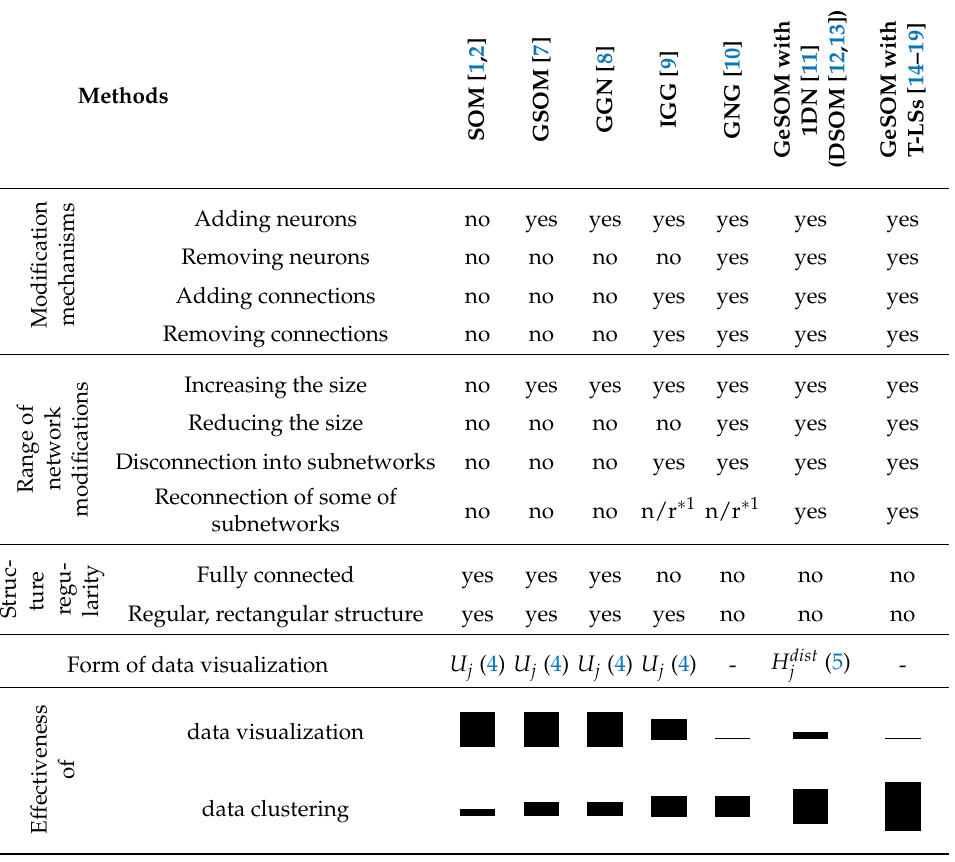
Table 1. Various modifications and generalizations of SOMs, their functionalities and data-visualization/ data-clustering